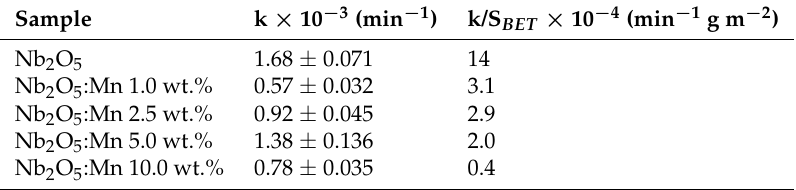
Table 4. Exchange rate constant obtained from the Rhodamina B Photodegradation tests.